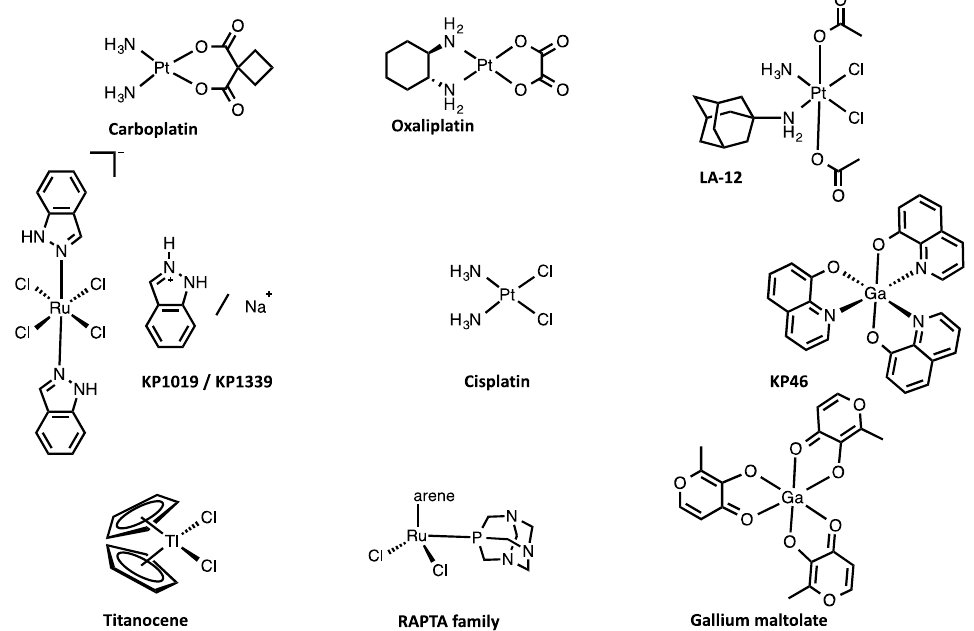
Figure 1. Chemical structures of representative Pt, Ru, Ti, and Ga anticancer drugs.